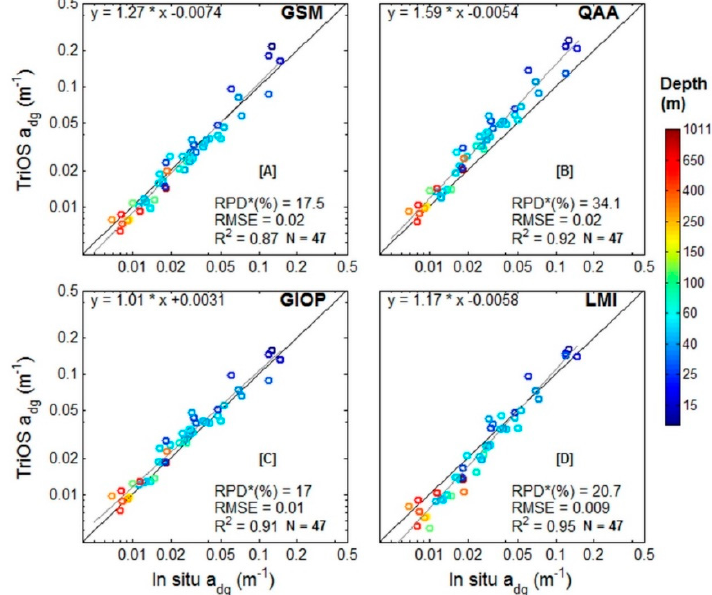
Figure 13. Comparisons between the in situ measured and modelled absorption of Coloured dissolved organic matter (CDOM) plus non-algal particles (NAP), the a dg at 443 nm using Remote sensing reflectance from TriOS radiometer (R rs T) (TriOS a dg ) obtained with: Garver-Siegel-Maritorena (GSM01) ( A ), Quasi-Analytical Algorithm (QAA) ( B ), Generalized IOP (GIOP) ( C ) and Linear Matrix Inversion (LMI) ( D ) (Number of samples = 47). Axes in log scale.